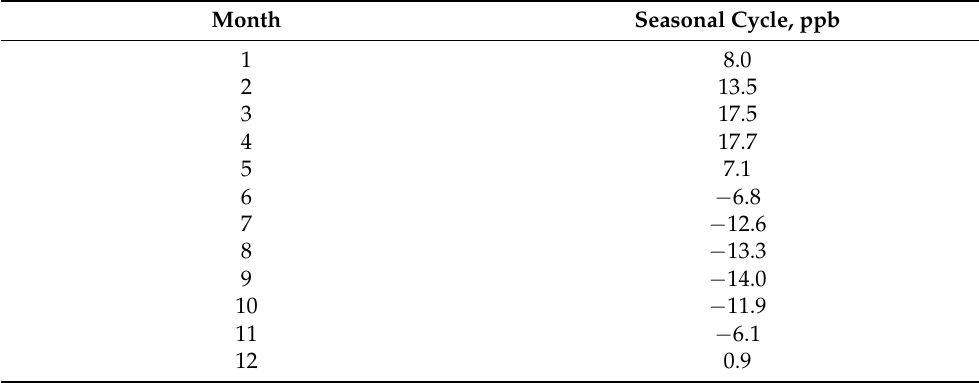
Table A2. Seasonal cycle of Xco in HNH, calculated for the period January 2004–December 2007.